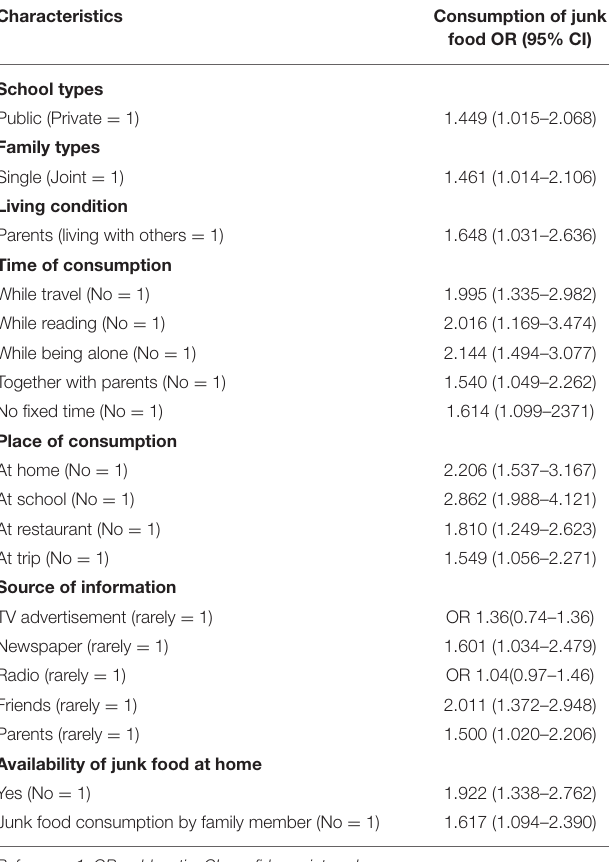
TABLE 7 | Relationship of different sociodemographic, individual, and behavioral factors with junk food consumption.